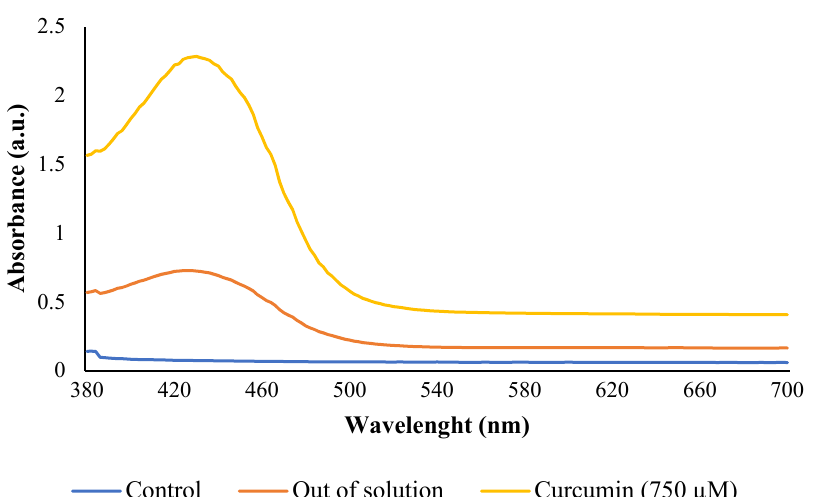
Figure 7. Maize extract absorption spectra after soaking in curcumin solution and illumination with blue light at 104.2 J · cm − 2 . Control maize kernels dipped in the solvent before illumination (propylene glycol); out of solution maize kernels dipped in 1000 µ M of curcumin in propylene glycol before illumination.